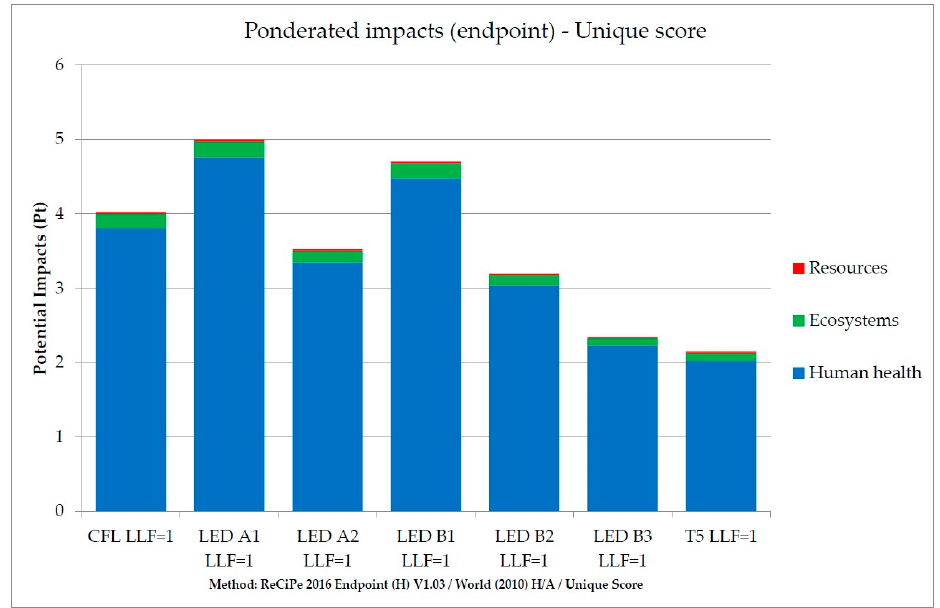
Figure 11. Endpoint potential impacts of lighting systems with a LLF = 1 (functional unit: 34.82 Mlm-h).